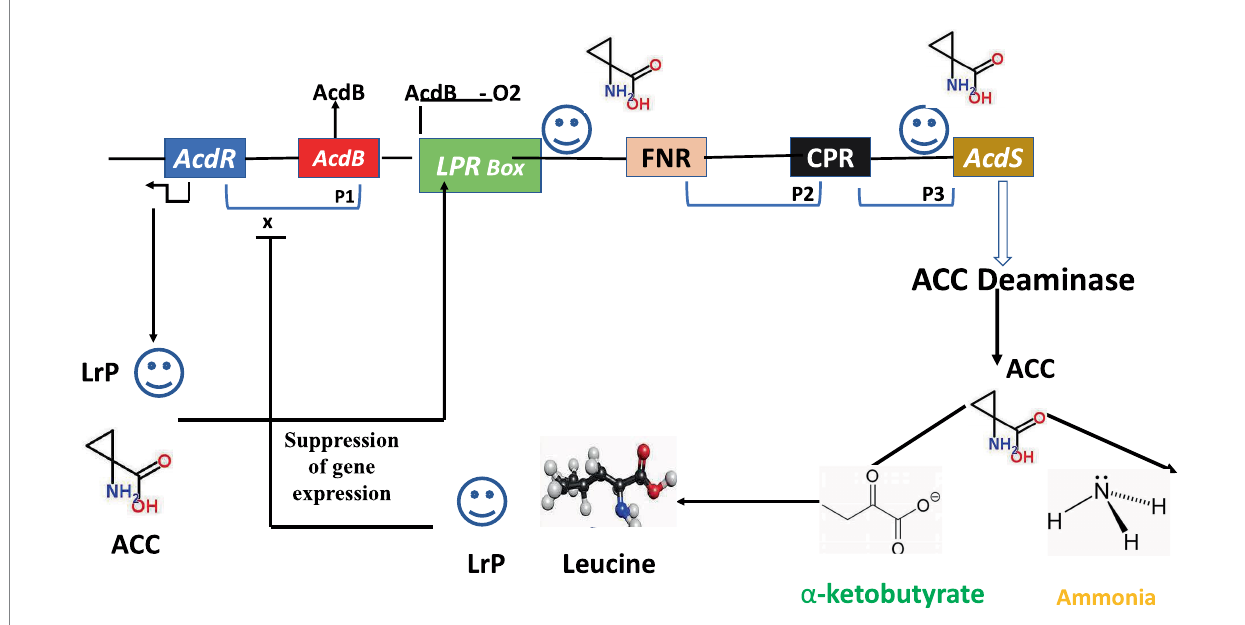
FIGURE 2 Regulatory circuits of AcdS gene expression in Pseudomonas putida UW4 and related bacteria. AcdR , regulatory gene for ACC deaminase; AcdB , encoding for glycerophosphoryl diester phosphodiester; LRP, leucine responsive protein; FNR, fumarate nitrate reductase protein; CRP, c-AMP receptor protein; AcdS , gene for encoding ACC